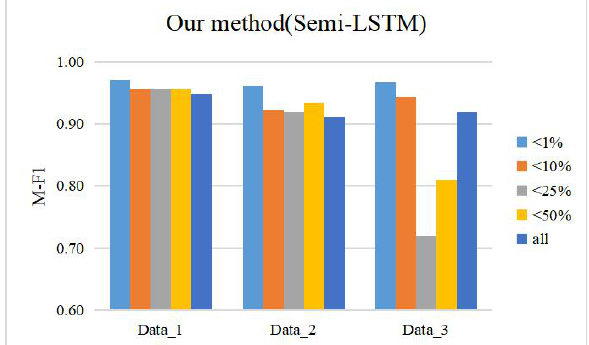
Figure 11. Overall accuracy of subdata sets with different degrees of cloud coverage via our proposed